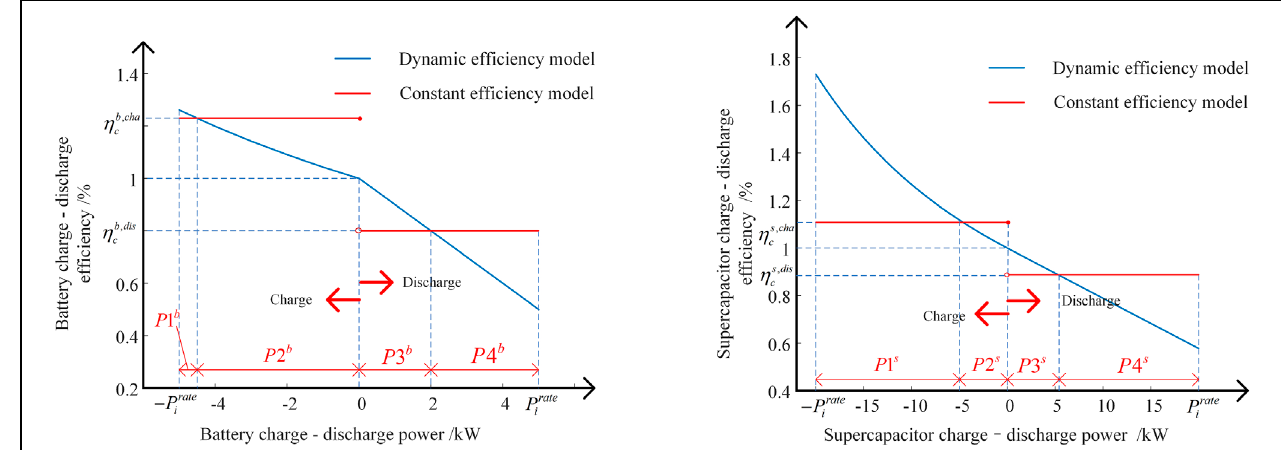
FIGURE 1 | Dynamic/constant efficiency curve of the energy storage unit with power.